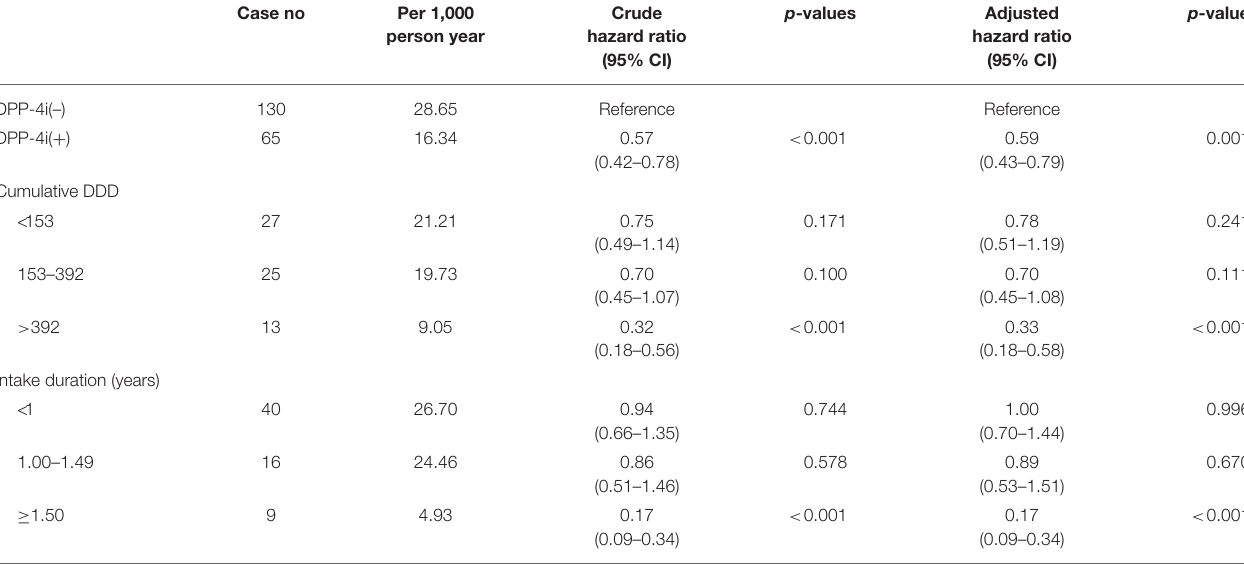
TABLE 2 | The risk of hepatocellular carcinoma in patients with type 2 DM and chronic HCV infection.